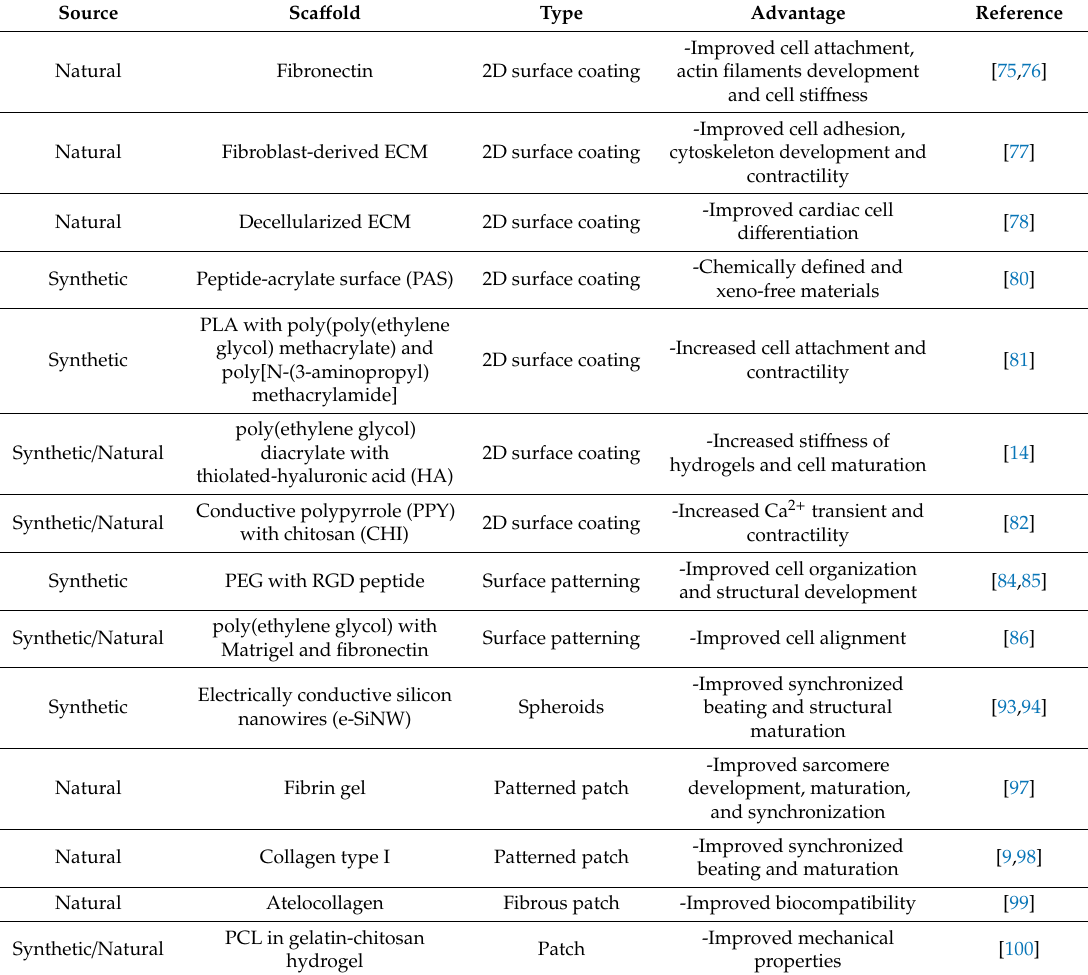
Table 1. Natural and synthetic biomaterials for cardiac tissue